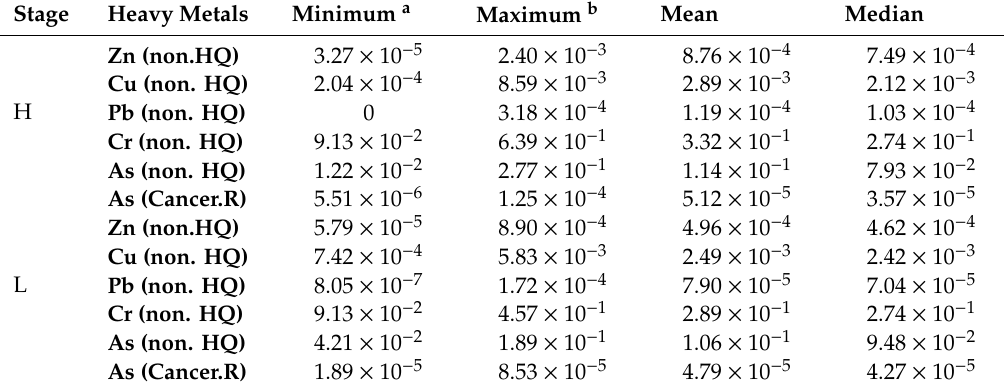
Table 4. Human health risk assessment including the noncarcinogenic hazard quotients (non. HQ) and carcinogenic risks (Cancer. R) from heavy metals in the river waters of the Issyk − Kul Basin during the period with high river flow (H) and the period with low river flow (L).